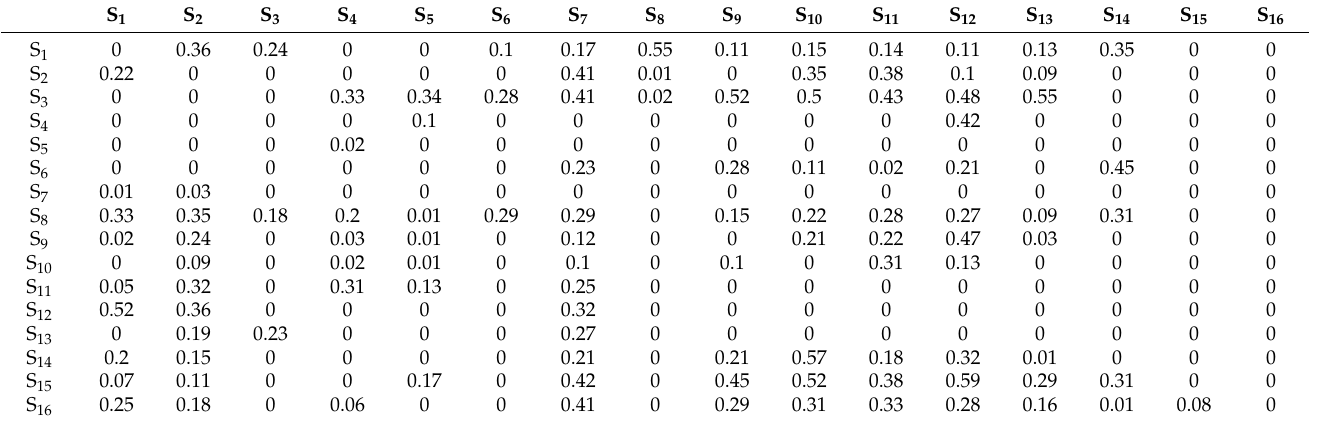
Table 4. Direct impact matrix of the causal factors of brittleness in lean–green manufacturing systems in the context of Industry